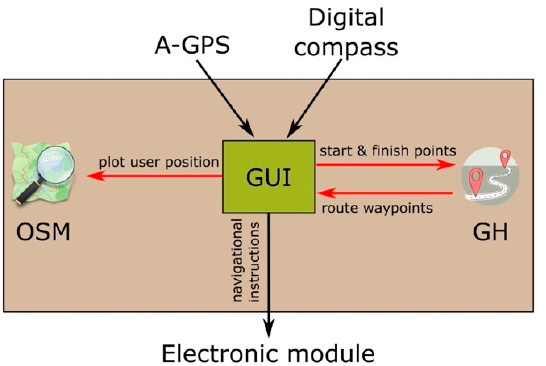
Figure 3. Overview of the AT device navigation software (mobile app). OSM: OpenStreetMap. GH: Graphhopper.